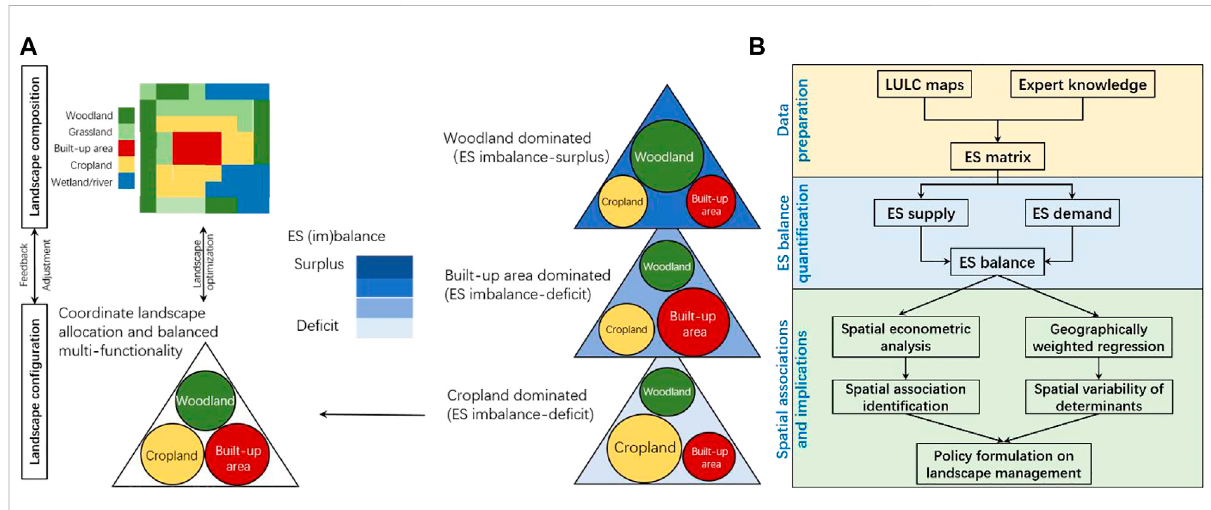
FIGURE 2 (A) Diagram of linkages between the ES balance and landscape composition and (B) study work fl ow. Woodlands, croplands, and built-up areas in the left column were the three dominant landscape categories, accounting for more than 90% of the total area, and were closely associated with ES supply, demand, and balance. The evolution of landscape composition and the associated ES balance are illustrated in (A) and Supplementary Figure